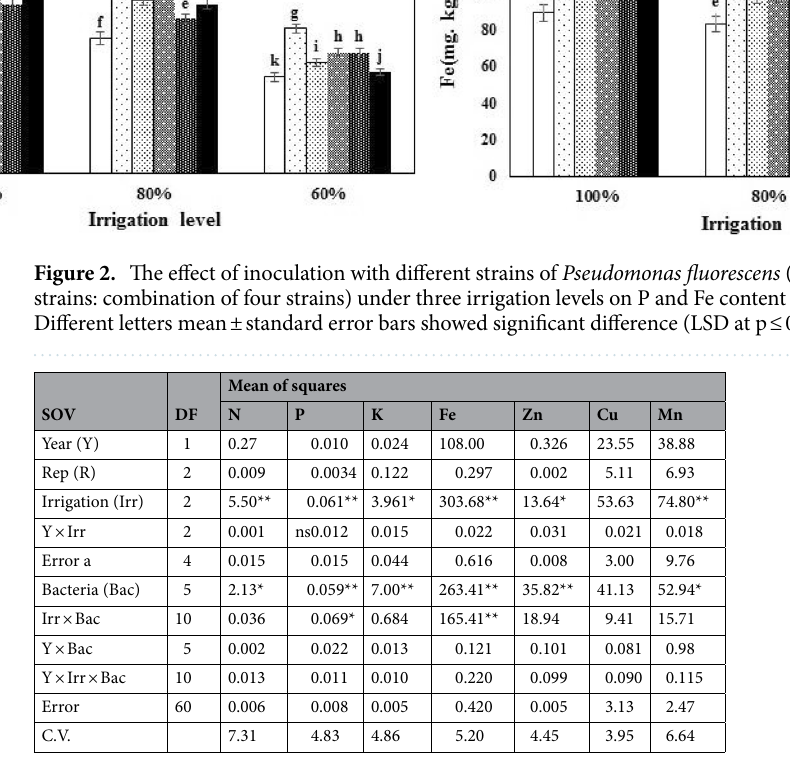
Table 3. Variance analysis of the effects of irrigation levels and bacterial inoculation on nutrients content of sweet corn leaf. *Indicates p ≤ 0.05; ** indicates p ≤ 0.01; C.V. indicates coefficient variance; Rep indicates replication (n = 3); DF indicates degree of freedom; S.O.V indicates source of